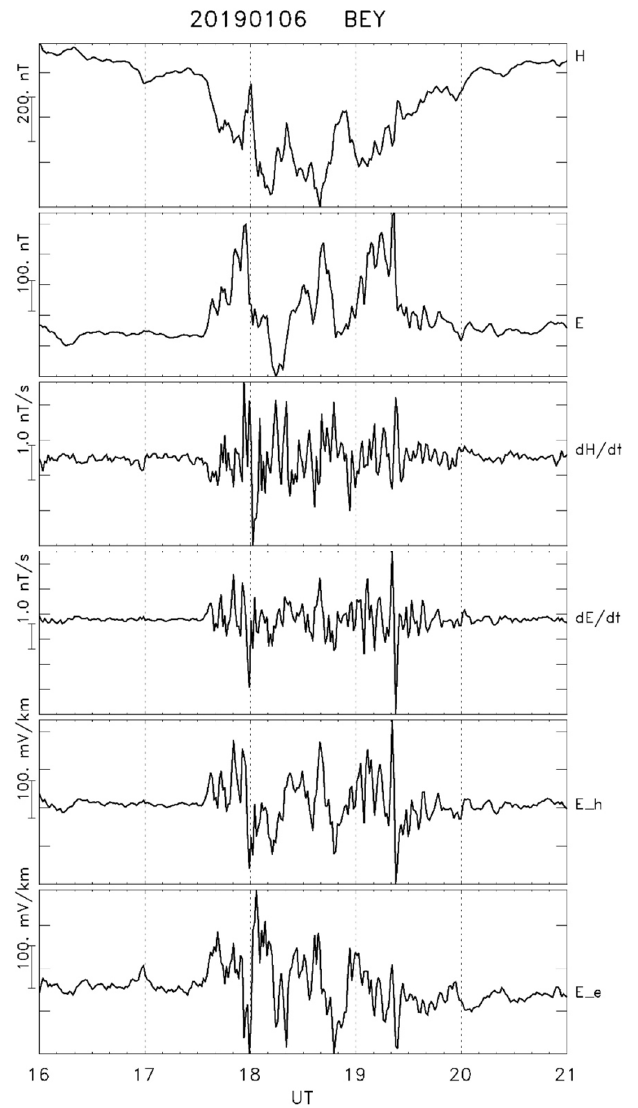
Figure 6. Combined magnetic and telluric field variations at station BEY on 6 January 2019 in the following order (from top to bottom ): magnetic H and E components, magnetic field variability d H /dt and d E /dt, and electrotelluric E H and E E components.